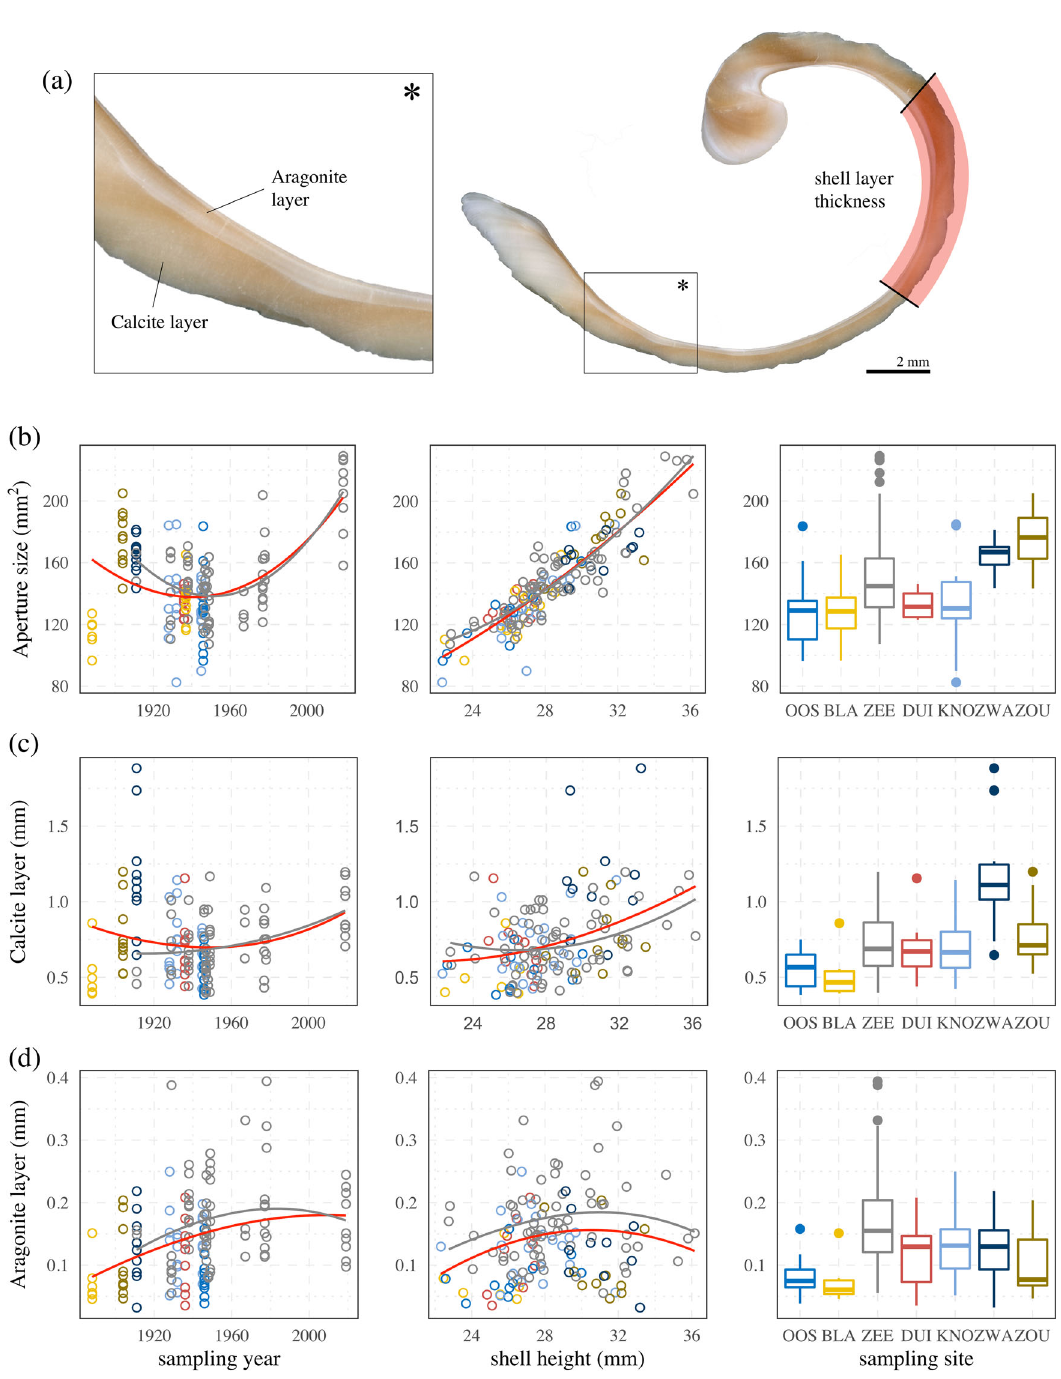
Fig. 1 Shell thickness and aperture size trends over the last century. a Image showing the section of shell used for the thickness analyses. The dorsal region where thickness measurements were carried out is highlighted in red. b Relationship of aperture size with sampling year, shell height and sampling sites. c Relationship of calcite layer thickness with sampling year, shell height and sampling sites. d Relationship of aragonite layer thickness with sampling year, shell height and sampling sites. Loess smoothing curves indicate trends for the whole dataset (red) and for samples collected at Zeebrugge only (blue). Sampling site abbreviations from west to east: OOS Oostende, BLA Blankenberge, ZEE Zeebrugge, DUI Duinbergen, KNO Knokke, ZWA Zwarte Polder, ZOU Zoutelande. Boxplot whiskers refer to the 1.5 interquartile